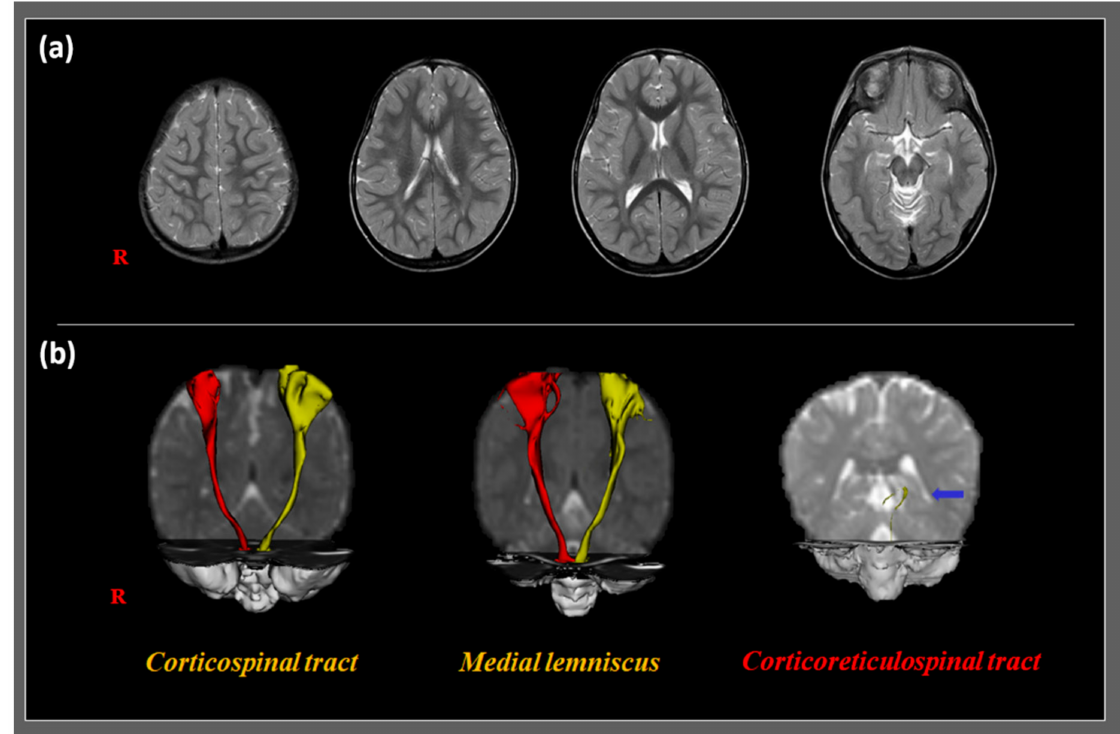
Figure 1. T2-weighted magnetic resonance images (upper row) and diffusion tensor tractography (DTT) images (lower row) of a 23-month-old boy with developmental coordination disorder showing gait dysfunction. ( a ) T2-weighted magnetic resonance images show no abnormal lesions. ( b ) DTT images revealing a disrupted corticoreticulospinal tract (blue arrow). However, the corticospinal tract and medial lemniscus show preserved integrity.